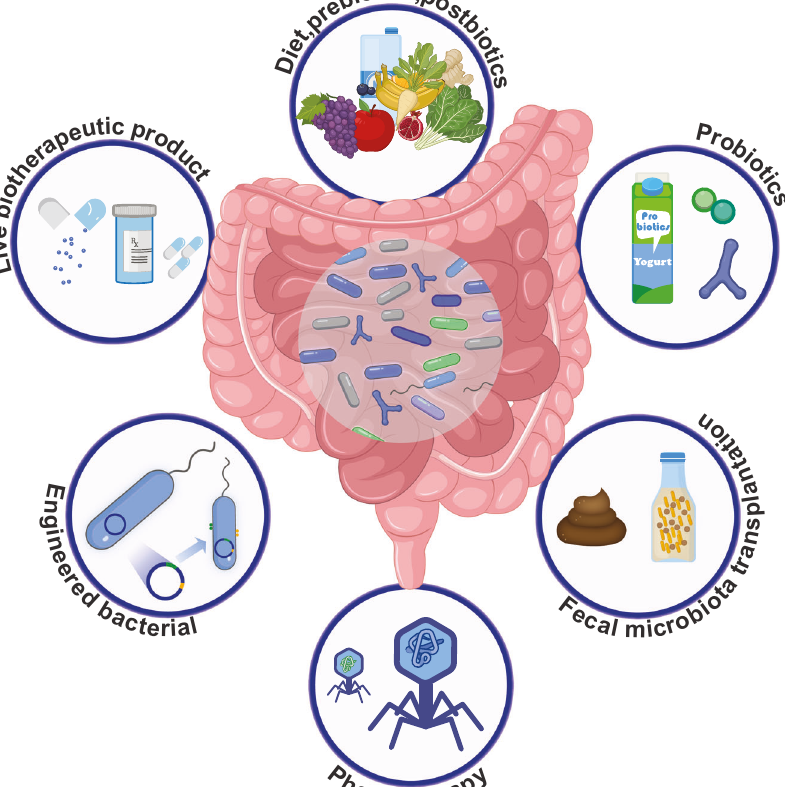
Fig. 6 Strategies to modify gut microbiota for disease